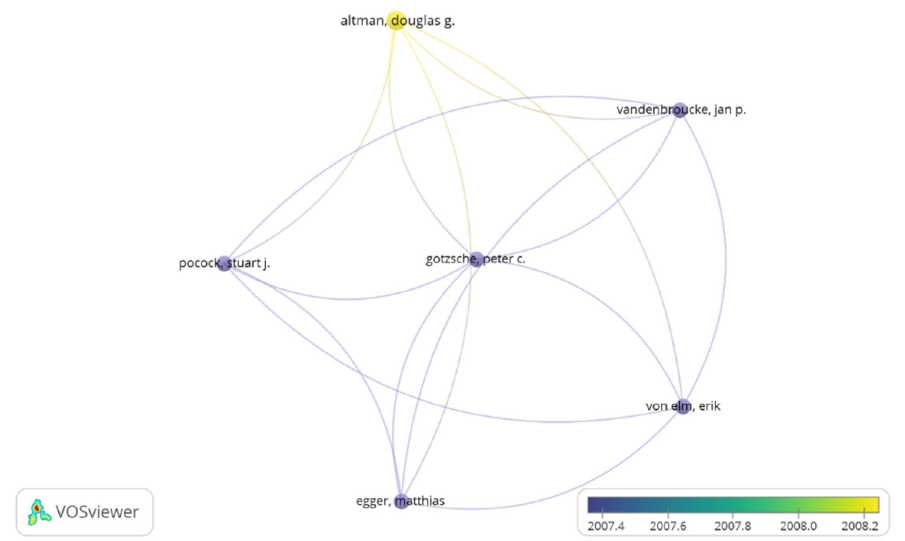
Figure 4. The author collaboration network. Note: The collaboration map of authors reflects the scientific research cooperation between them. The circle/node signifies the authors; size of the circle/node signifies the number of articles. The lines denote the authors’ collaboration strength, and each color signifies a cluster.